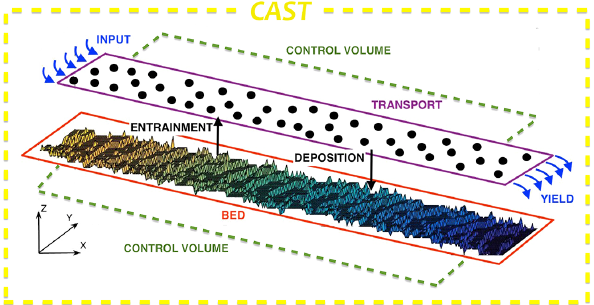
Figure 1. Diagram of the model. The space is discretized in a longi- tudinal dimension X and a transversal dimension Y . Bed elevation is given by the coordinate Z . Particles can be either in the bed ma- trix or in the transport matrix. They can enter the transport matrix as sediment input from the upper boundary or by entrainment from the bed, while they can leave the transport matrix as sediment out- put or by deposition on the bed. Sediment is input at the upstream boundary and simulated as sediment yield leaving the downstream